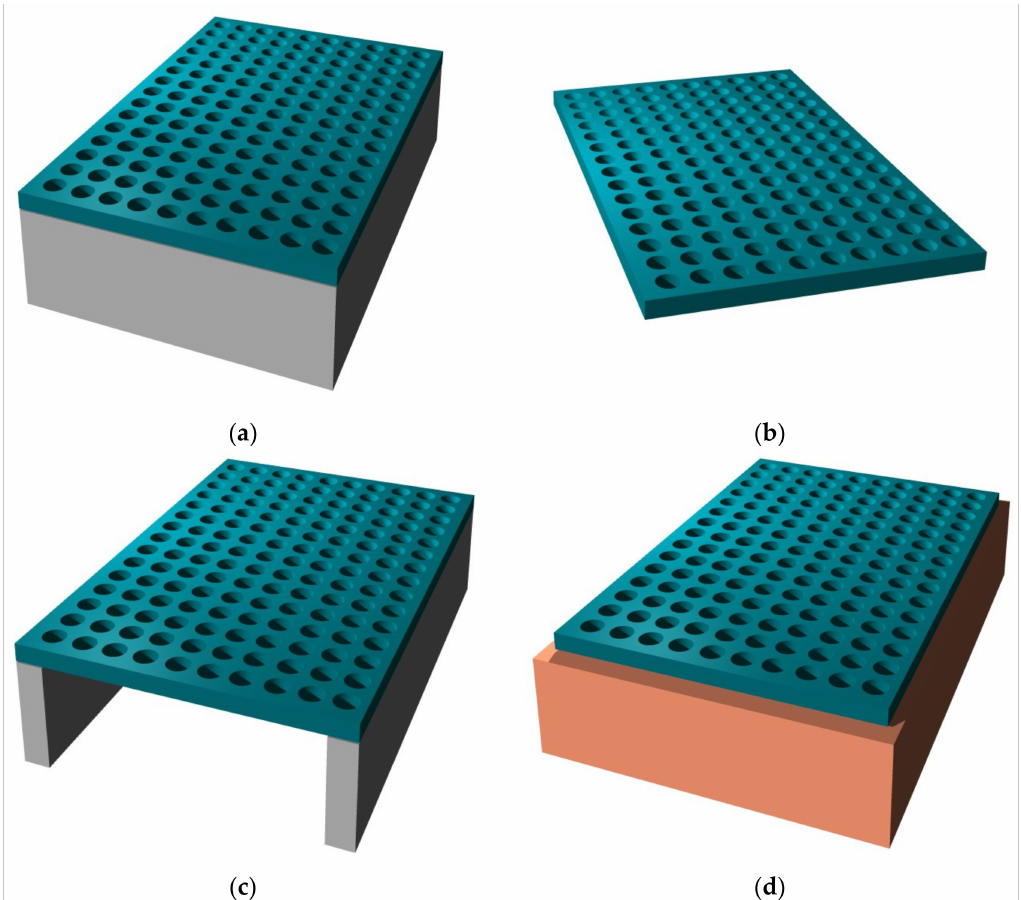
Figure 1. Top-down method for nanomembrane fabrication by sacrificial etching. ( a )Starting struc- ture where the membrane material is deposited to a sacrificial substrate. The membrane is then functionalized by scatterers (in this case, a square lattice of nanoapertures; this step may be done, e.g., by focused ion beam etching and is not shown in the figure); ( b ) the sacrificial support is completely removed by wet etching and the membrane is left free-floating in the solution (in re- ality the membrane will not be perfectly flat and its surface will freely undulate in the solution); ( c ) one possible way to deal with the membrane is to transfer it to a support. For the sake of clarity, the front part of the support is not shown; the support can be fabricated immediately after the step ( a ) if only a part of the sacrificial support had been removed, using, e.g., a lithographic mask and bulk micromachining (anisotropic wet etching); ( d ) another alternative, where the free-floating membrane has been transferred to another substrate, different from the original